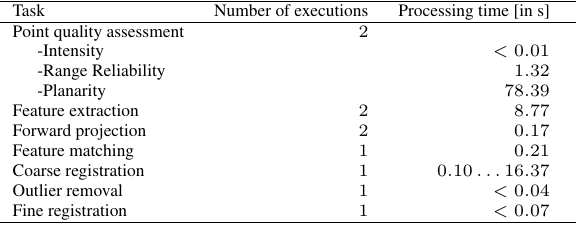
Table 1. Required processing times for different subtasks of a pairwise registration.